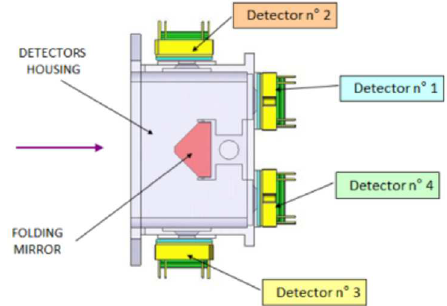
Figure 1. Ven μ s Focal Plane and its 4 tri-detectors.